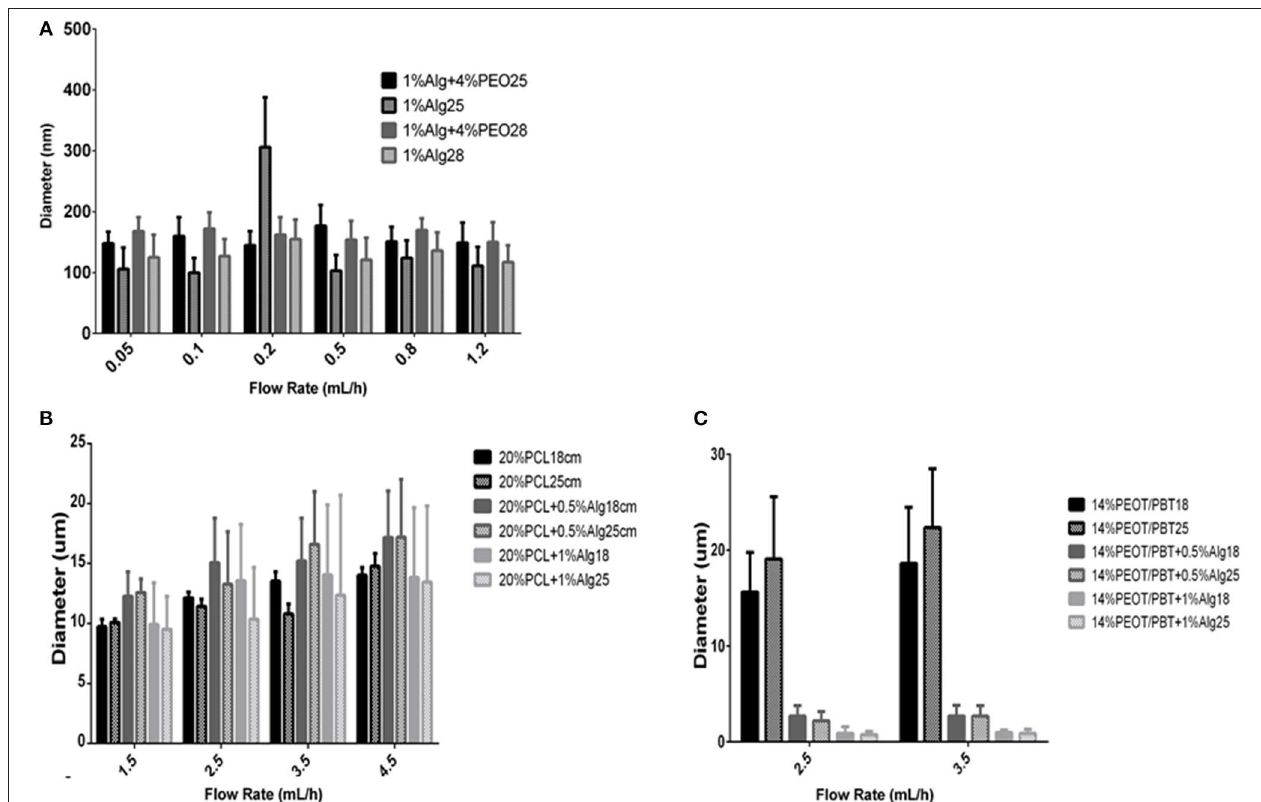
FIGURE 3 | Effect of the flow rate and air gap on fiber diameter of different materials. (A) Effect of the flow rate (0.05–1.2 mL/h) and air gap (25 and 28cm) on fiber diameter of Alginate/PEO scaffolds prepared from 1% Alginate + 4% PEO solutions and the same scaffolds after alginate crosslinking and PEO removal; (B) Effect of the flow rate (1.5–4.5 mL/h) and air gap (18 and 25cm) on fiber diameter of PCL and PCL/Alginate blended electrospun scaffolds (20% PCL, 20% PCL + 0.5% Alginate, 20% PCL + 1% Alginate); (C) effect of the flow rate (1.5–4.5 mL/h) and air gap (18 and 25cm) on fiber diameter of PEOT/PBT and PEOT/PBT/Alginate blended electrospun scaffolds (14% PEOT/PBT, 14% PEOT/PBT + 0.5% Alginate, 14% PEOT/PBT + 1%